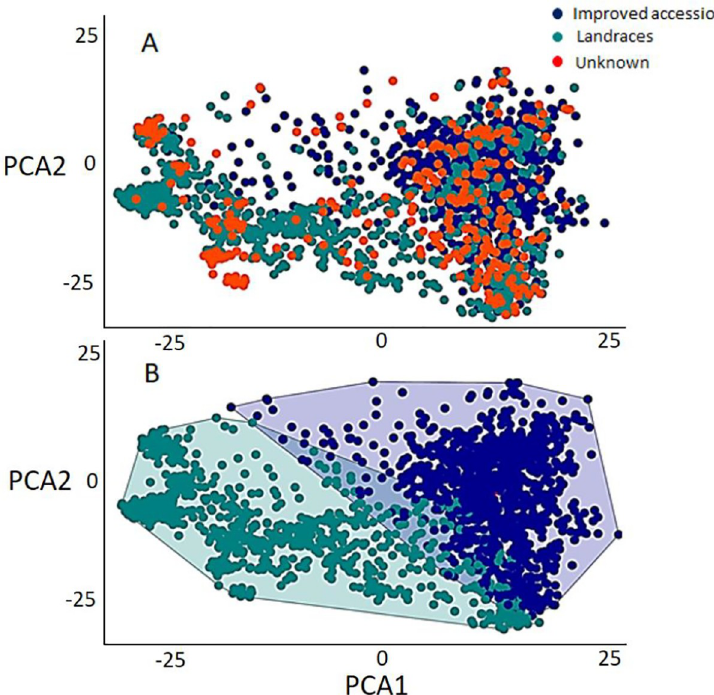
Fig 1. Accessions distribution based on the improvement degree, i.e, improved, landraces and unknown, using the first two principal components, before [A] and after [B] classifying the unknown accessions.